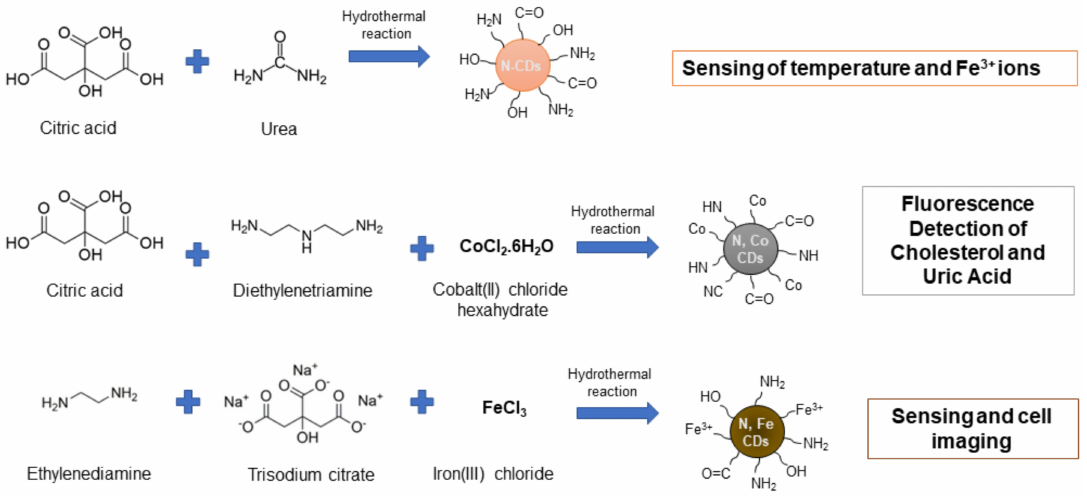
Figure 4. Schematic illustration of the preparation of various CDs made of carbon precursors and metal ions and their applications. Adapted from